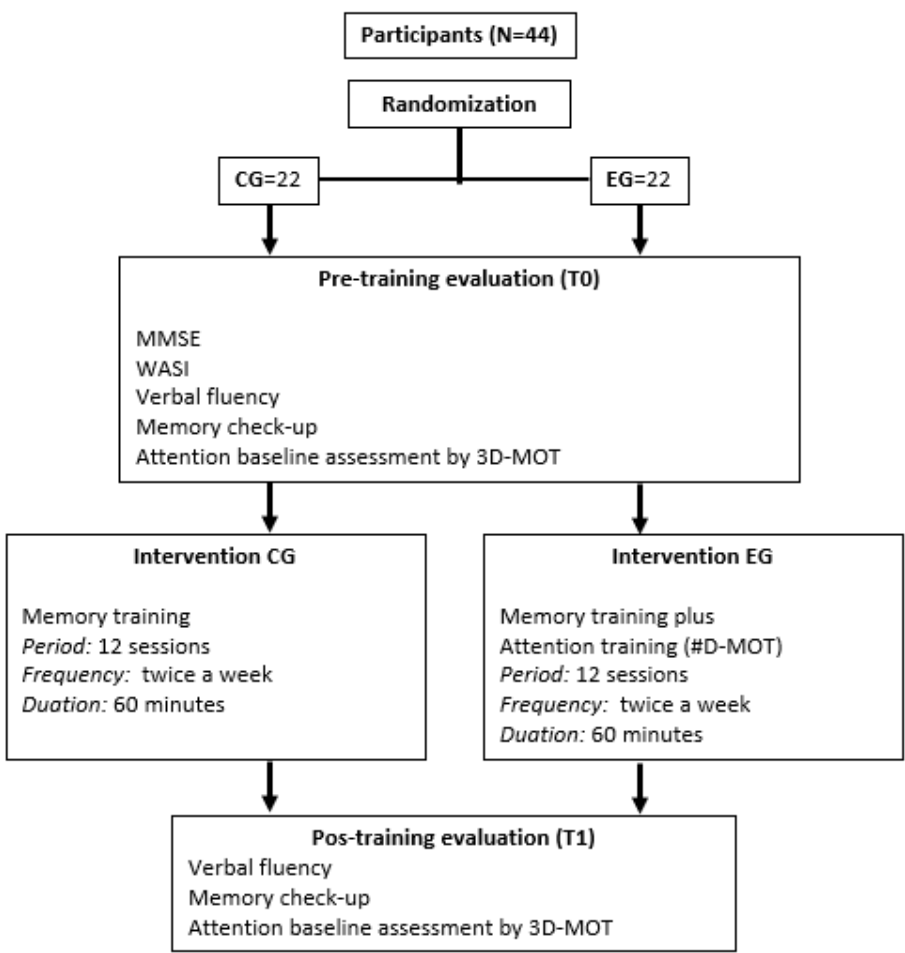
Figure 1. Sample